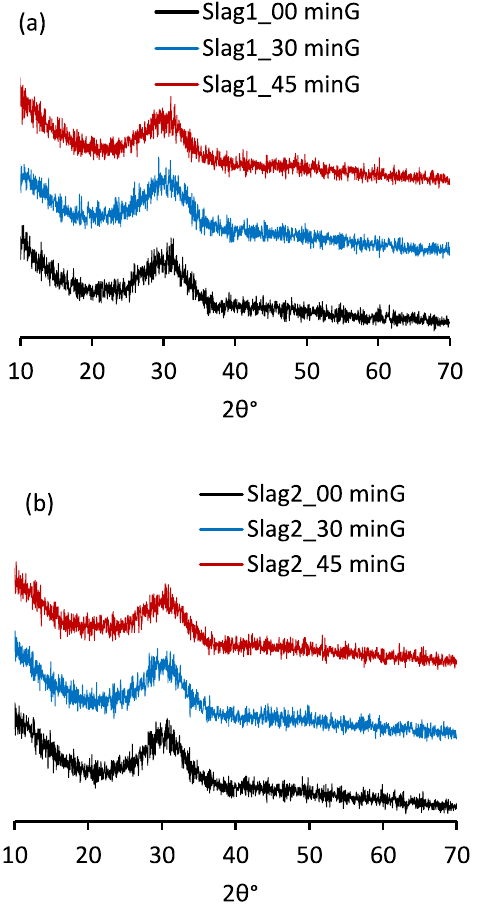
Figure 1. The XRD patterns of type 1 and type 2